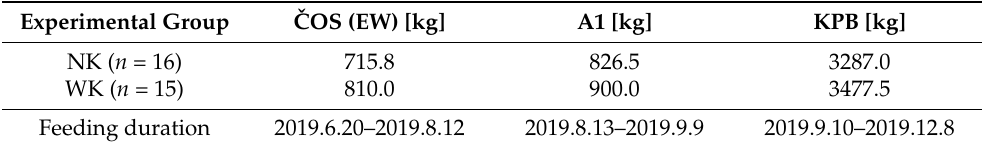
Table 1. The fodder consumption of the experimental group of pigs (WK) and the control group of pigs (NK).